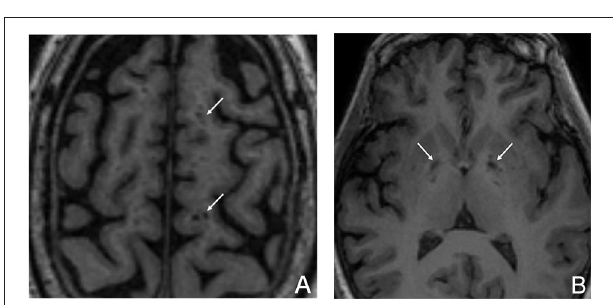
FIGURE 2 | ePVS in the centrum ovale (A) and in the basal ganglia (B)